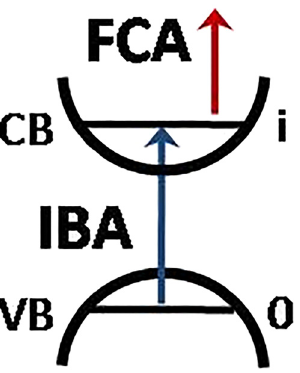
Figure 1: Conceptual sketch of a quantum two-state system comprising lower level 0 and upper level i . VB = valence band, CB = conduction band, IBA = interband absorption, FCA = free carrier